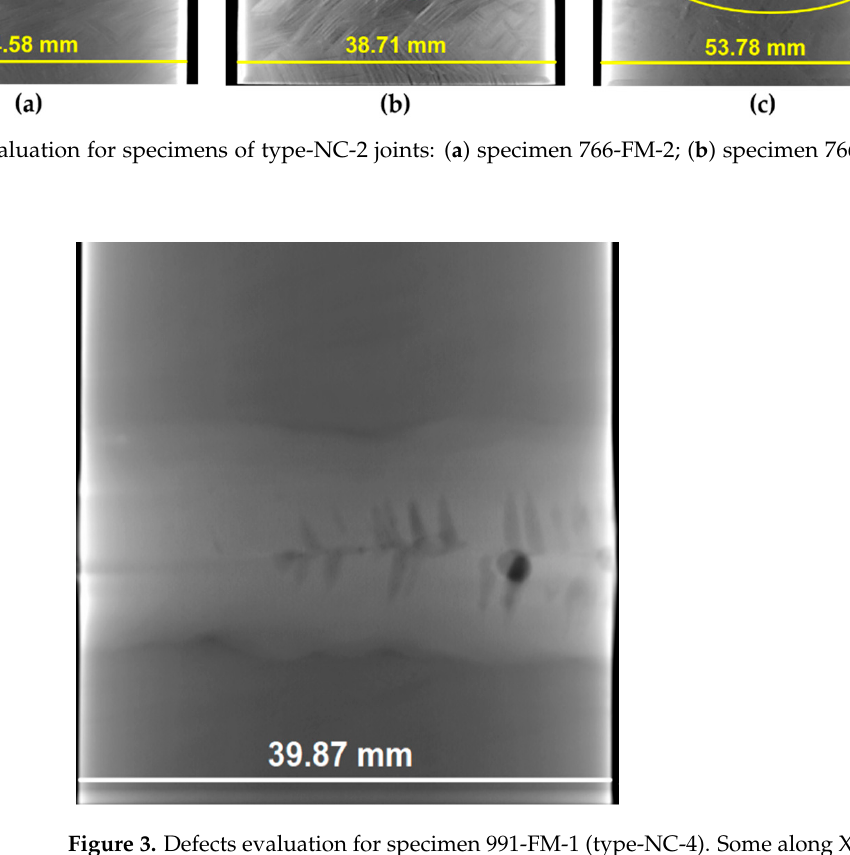
Figure 3. Defects evaluation for specimen 991-FM-1 (type-NC-4). Some along X-rays of the joint.